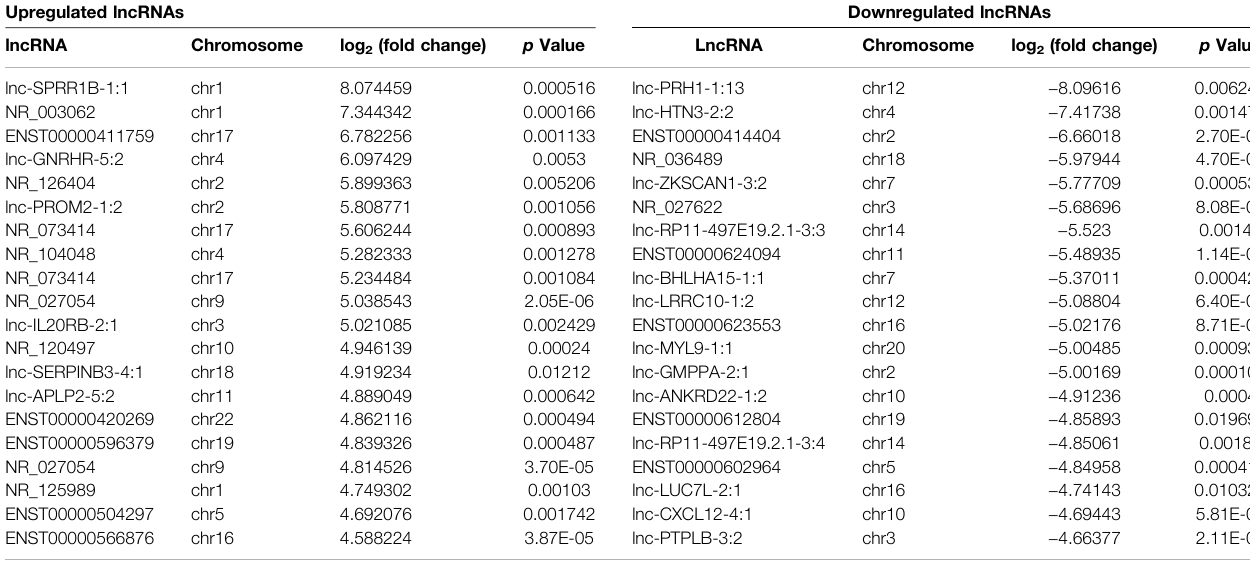
TABLE 2 | Top 20 differentially expressed lncRNAs in SNIP tissues detected by microarray assay. Upregulated lncRNAs